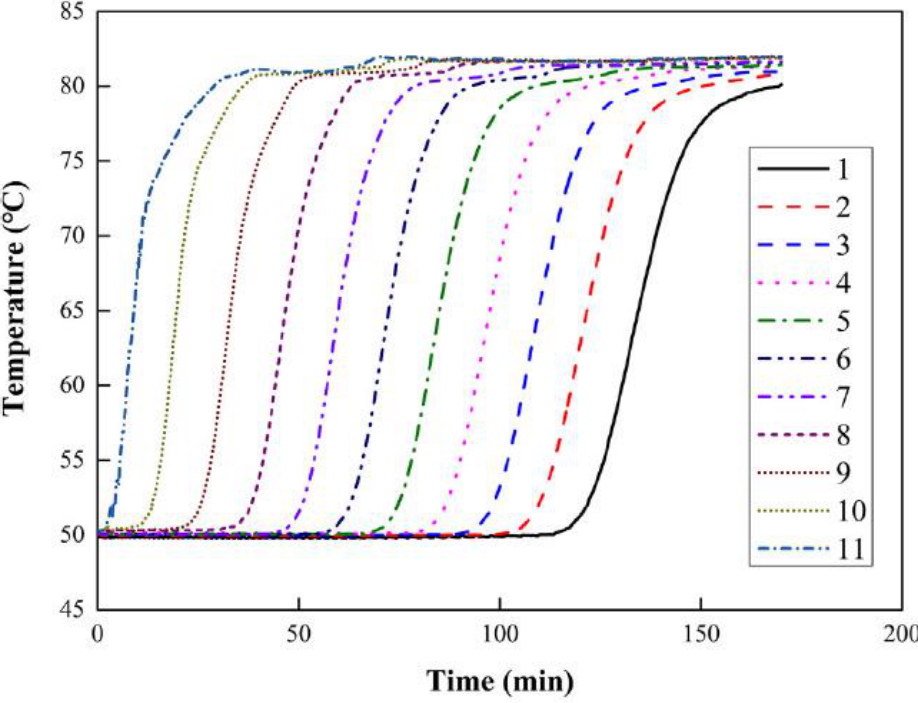
Figure 3. Temperature profiles at various measurement points inside the tank obtained during charging it from 50 ◦ C to 83 ◦ C with a flow of 0.3 m 3 /h. The layers of the tank are numbered as in Figure 1 (source: [29]).